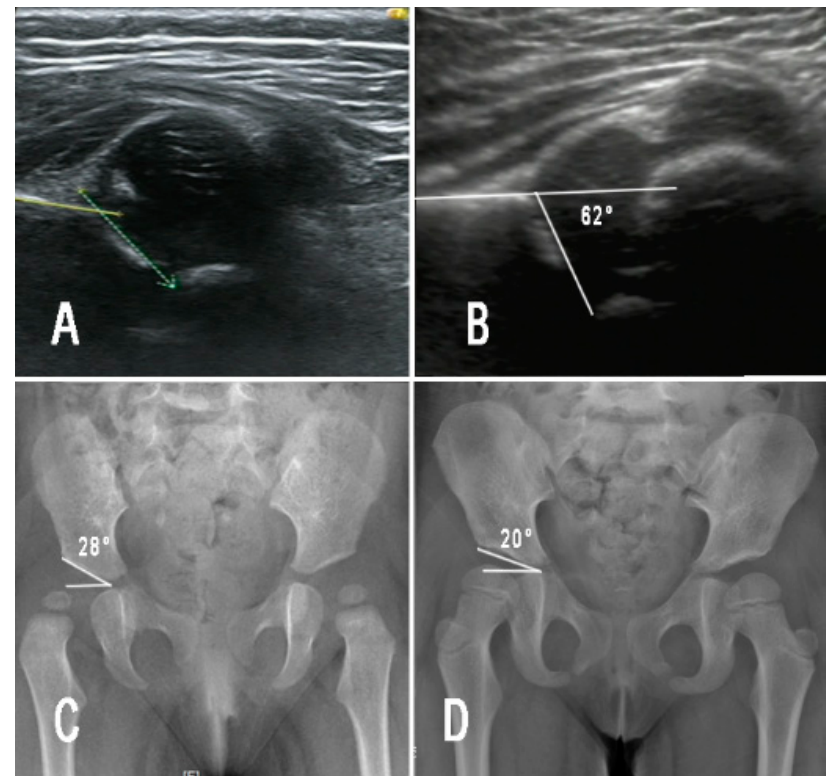
Figure 1. Female patient aged 3 months with right DDH (Graf type IV) ( A ), treated by PH for three months and achieved Graf type I ( B ), then the PH treatment was terminated. However, radiographic examination showed significant subluxation on the right hip 6 months later ( C ), and then the patient was treated by a night time abduction brace. At final follow-up (4 years old), the hip recovered to normal ( D ).